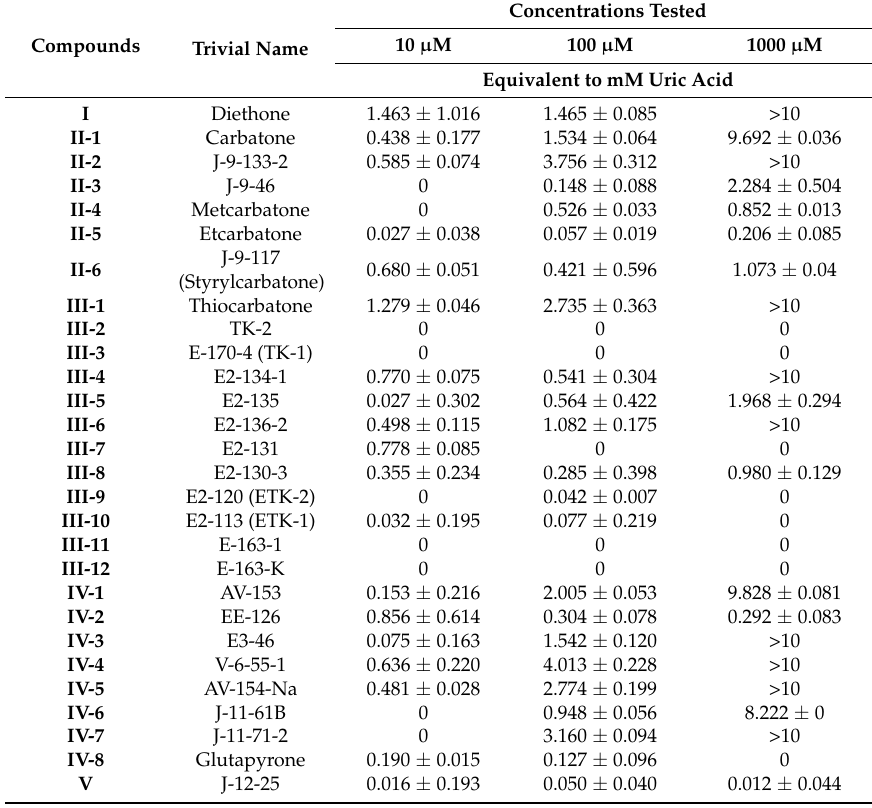
Table 2. Total antioxidant capacity of selected compounds expressed as equivalent to mM uric acid.